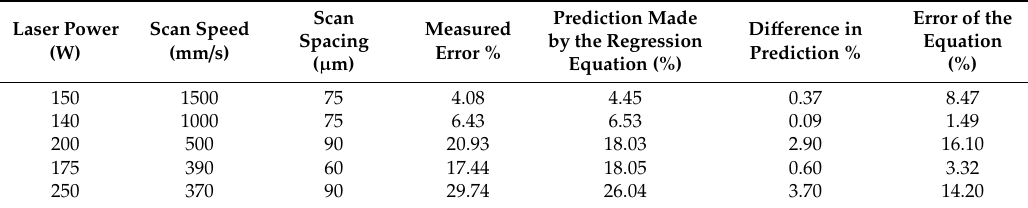
Table 3. Test results.